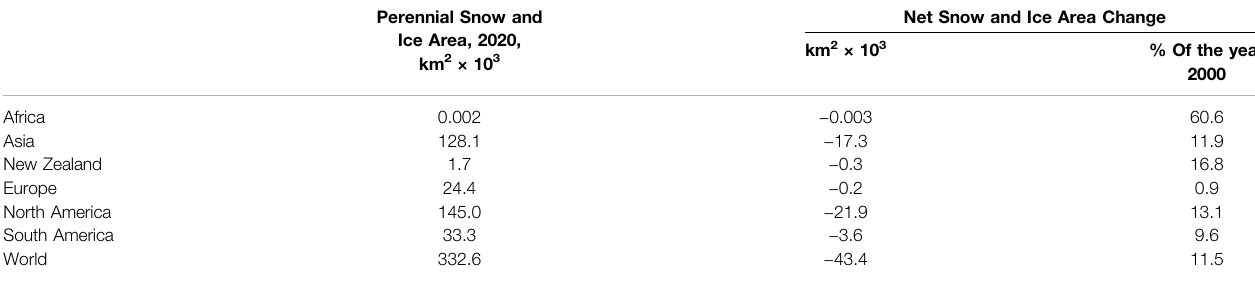
TABLE 5 | Map-based perennial snow and ice extent and reduction area, 2000 –